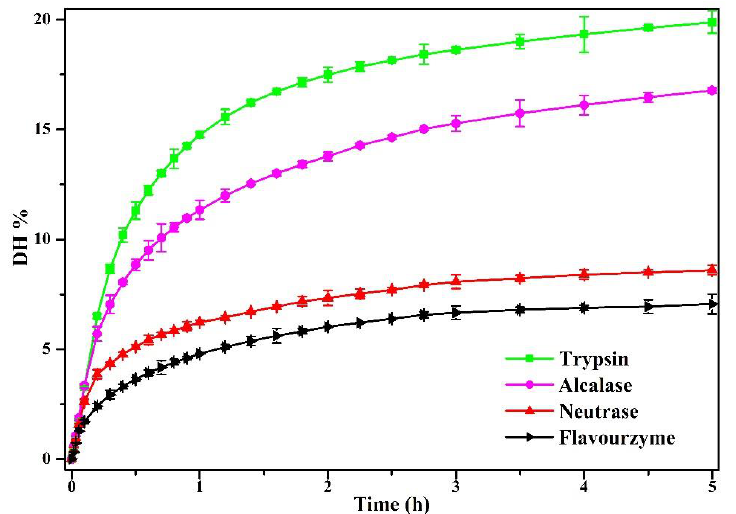
Figure 1. The DH of PP enzymolyzed by four enzymes (alcalase, neutrase, flavourzyme, and trypsin) using pH-stat method for 5 h.